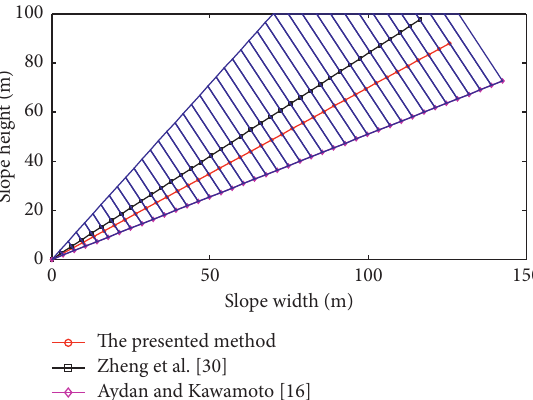
Figure 6: Slope failure planes of the slate slope in South Anhui in China obtained using different